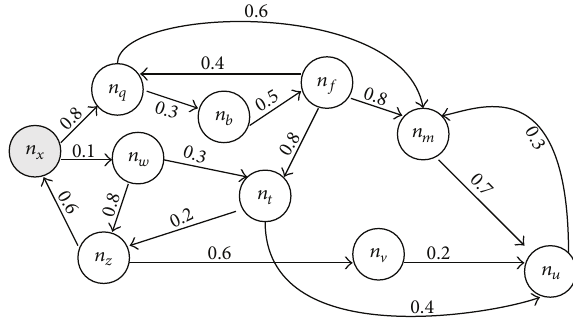
Figure 8: Example of trust chain 𝐺 𝑥